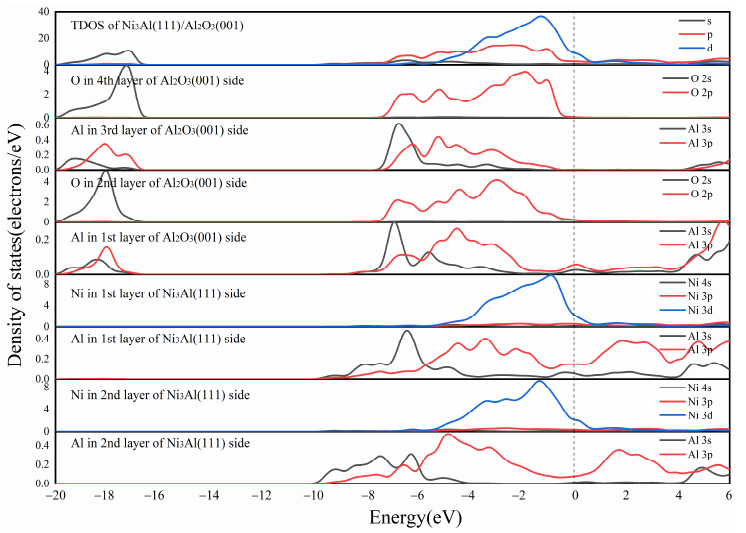
Figure 4. Total DOS and PDOS of the interfacial atoms in the Ni 3 Al(111)/Al 2 O 3 (001) system. Population analysis was used to determine the distribution of electrons in each atomic orbital. This analysis can reveal the covalent bond strength formed between the constituent atoms [35]. A larger positive value of the Mulliken overlap population indi- cates that the electron clouds overlap and that the covalent bond between the atoms is strong. On the other hand, a negative value indicates that the electron clouds do not